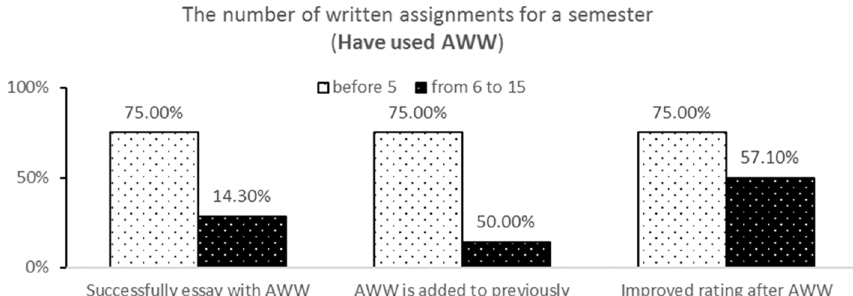
Fig. 8 Frequency of positive questions by number of written assignments for a semester when using AWW